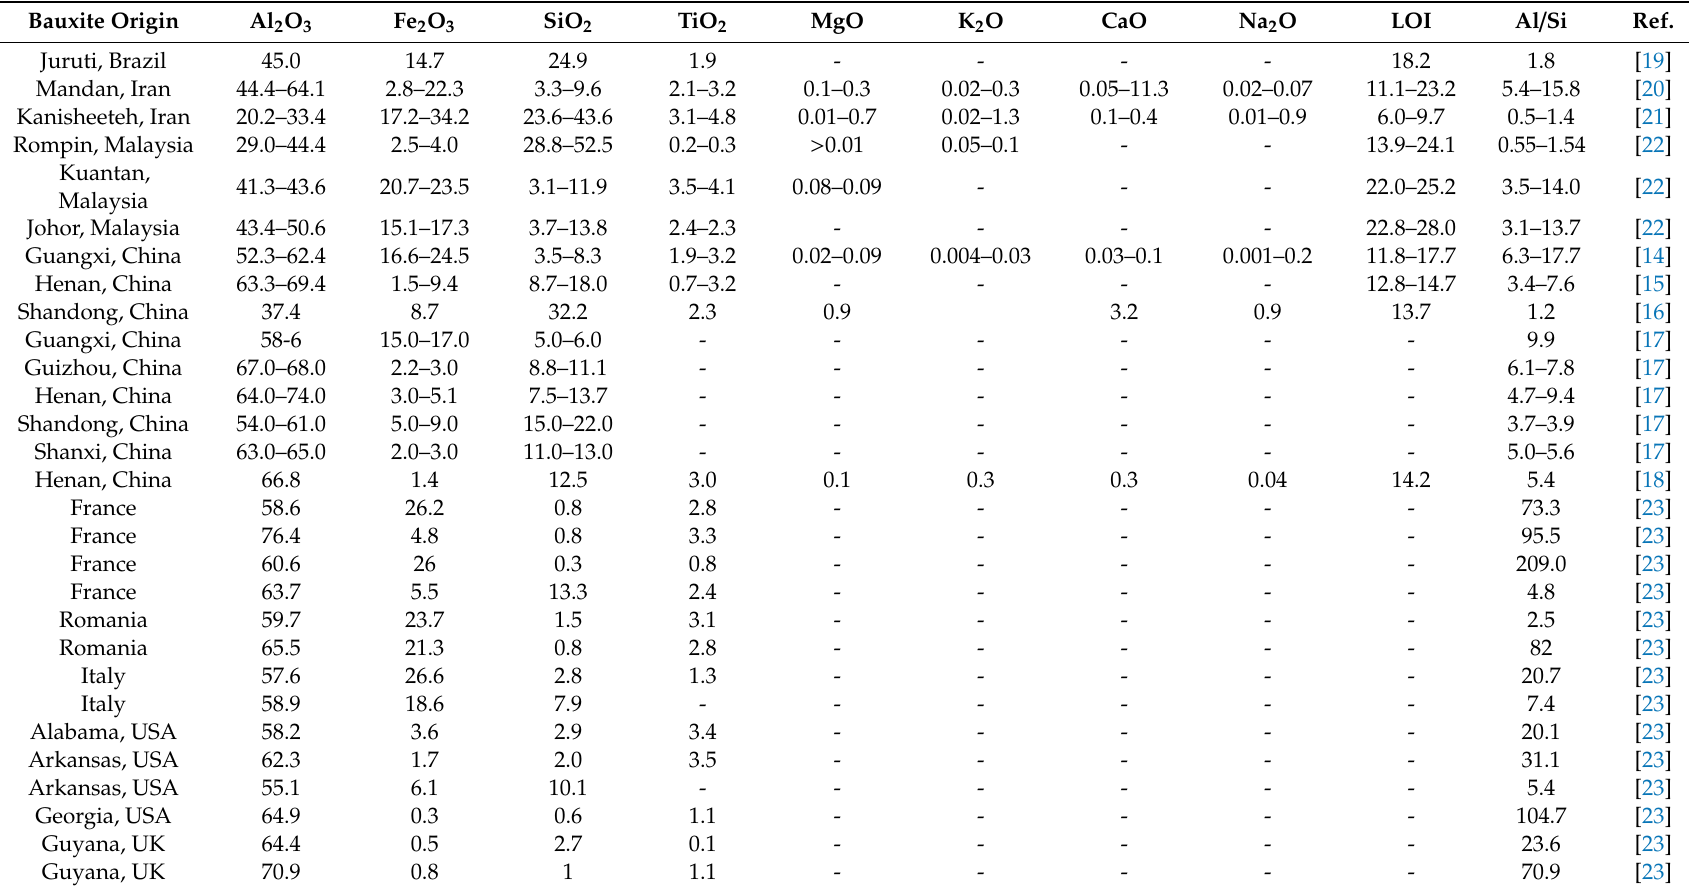
Table 1. The major chemical compositions (oxide wt.%), loss on ignition (LOI, wt.%) and Al / Si in bauxite over the